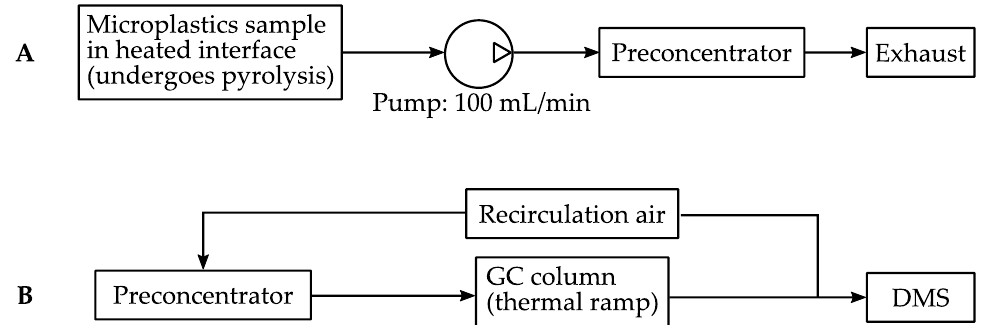
Figure 3. Block diagram showing typical microAnalyzer operation, using the microplastics applica- tion as an example. ( A ) MP samples are collected and adsorbed onto a preconcentrator. Sampling time can be controlled via pump duration. ( B ) After sampling, the preconcentrator is heated, releasing the sample; the sample travels through the GC column (with ambient air as carrier gas), and eluted compounds are detected via the DMS